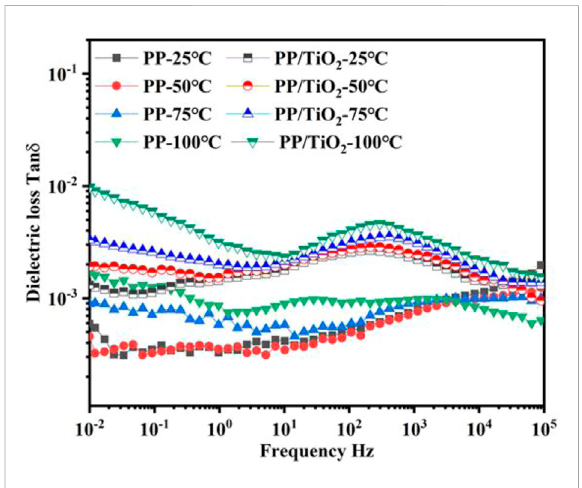
FIGURE 11 Dielectric loss spectrum at different temperatures.